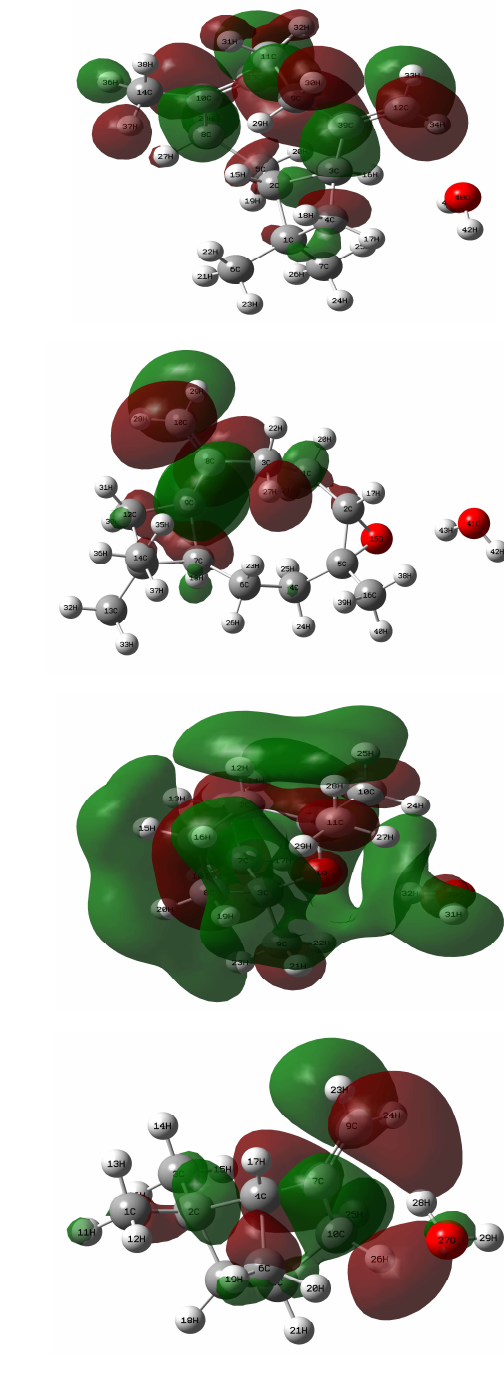
Figure 1. HOMO–LUMO plots of the binary mixtures ( α -cubebene–water ( a ), β -caryophyllene–water ( b ), caryophyllene oxide–water ( c ), 1,8-cineole–water ( d ), and β -pinene–water ( e )). HOMO and LUMO energies (E HOMO and E LUMO ), energy gap (Eg), electronegativity (χ), electron affinity (EA), softness (ζ), chemical potential (μ), ionization potential (IP), hardness (η), global electrophilicity index (ω), optical softness (σ ˳ ), maximum charge transfer index (∆Nmax), and nucleophilicity index (N) for the α-cubebene–water, β-cary- ophyllene–water, caryophyllene oxide–water, 1,8-cineole–water, and β-pinene–water mixtures were computed using the B3LYP/6–31 G (d,p) basis set. The data are given in